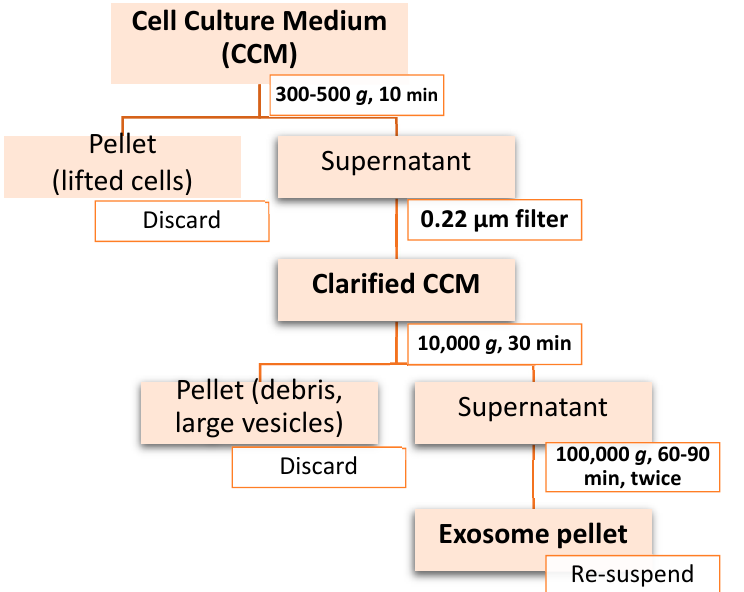
ff erential ultracentrifugation for exosome Figure 1. Workflow of differential ultracentrifugation for exosome isolation. Figure 1. Workflow of di